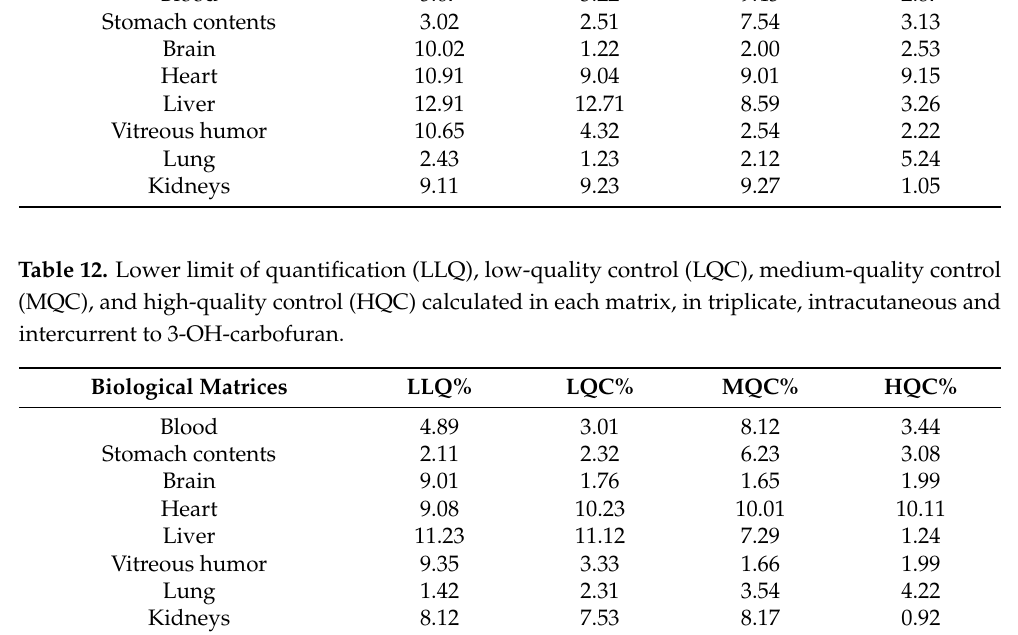
Table 13. Presentation of mean recovery data in % of all analytes and different biological matrices [54].